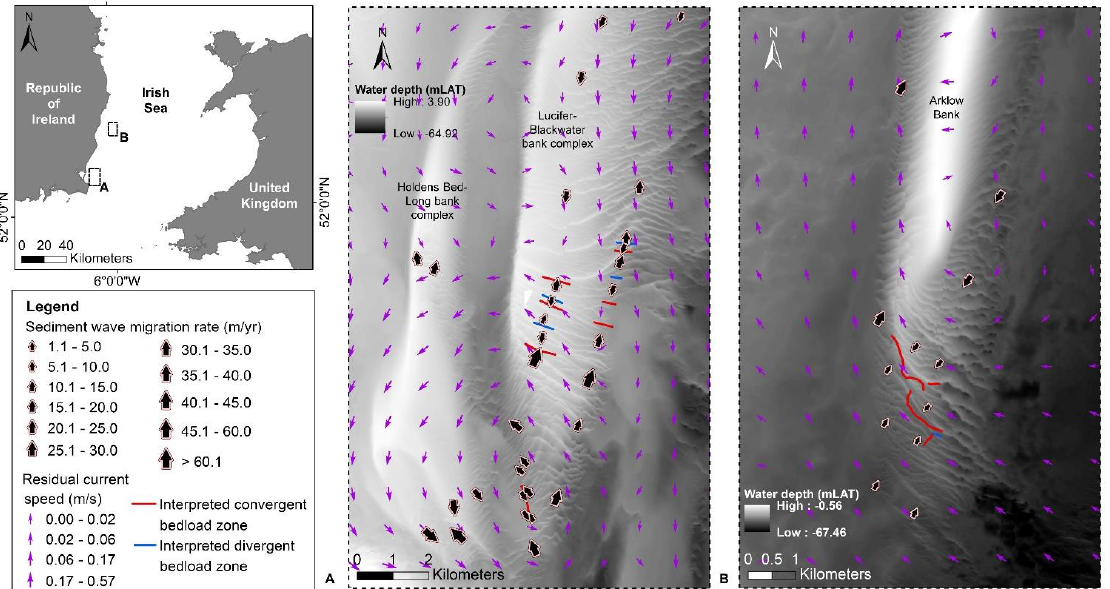
Figure 12. Newly derived sediment wave migration rates and bedload transport divergence and convergence zones overlain by modelled residual tidal current vectors at ( A ) the southern extent of Lucifer–Blackwater and Holden’s Bed–Long Bank complexes, and ( B ) the southern half of Arklow Bank in the Irish Sea. Bathymetry source: composite map produced from INFOMAR datasets (https://www.infomar.ie/data [Accessed: 10 June